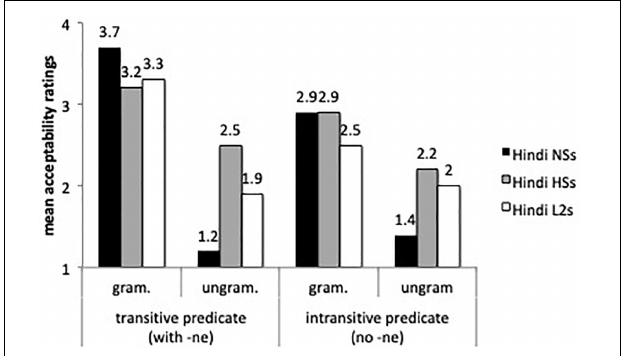
FIGURE 3 | Mean acceptability ratings for ergative marking (- ne ) with transitive and intransitive perfective